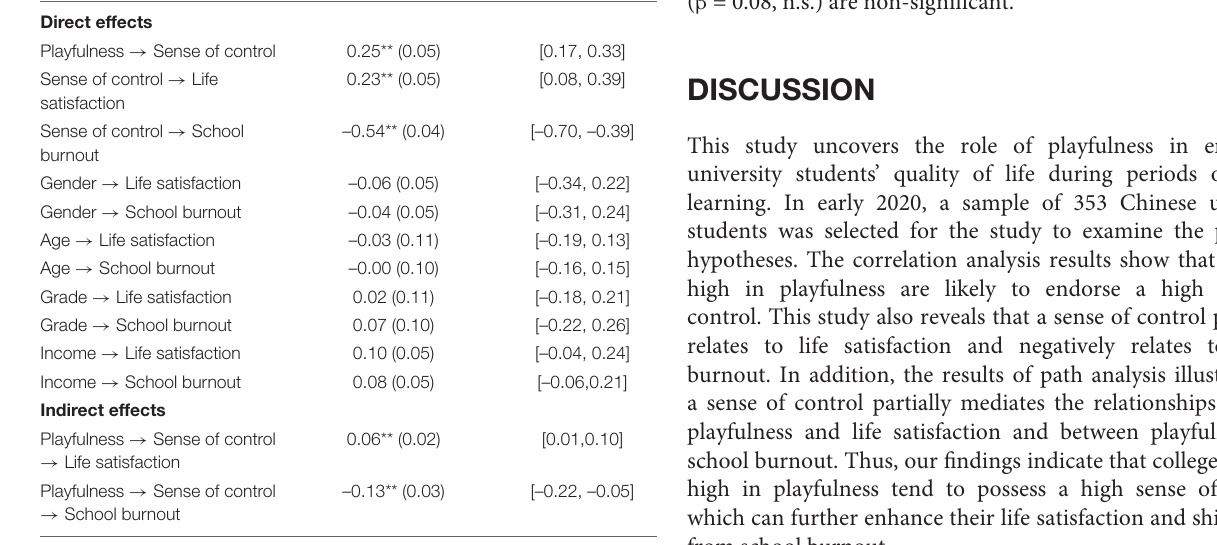
TABLE 2 | The direct and indirect effects of playfulness on life satisfaction and school burnout and 95% confidence intervals. Estimated effect